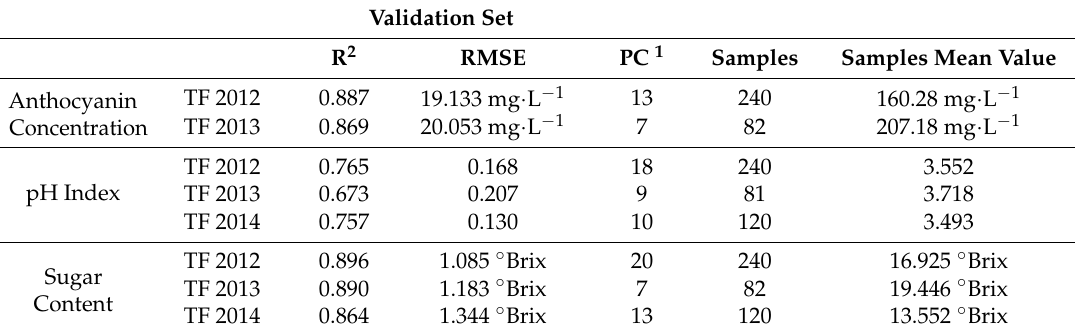
Table 5. Results obtained in the validation set for the determination of the anthocyanin concentration, pH index and sugar content of the wine grape